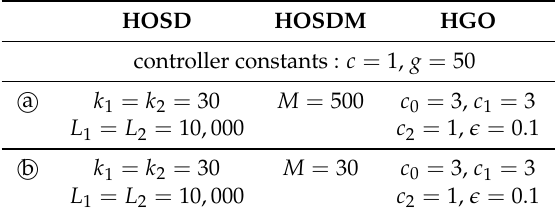
Table 2. Simulation parameter